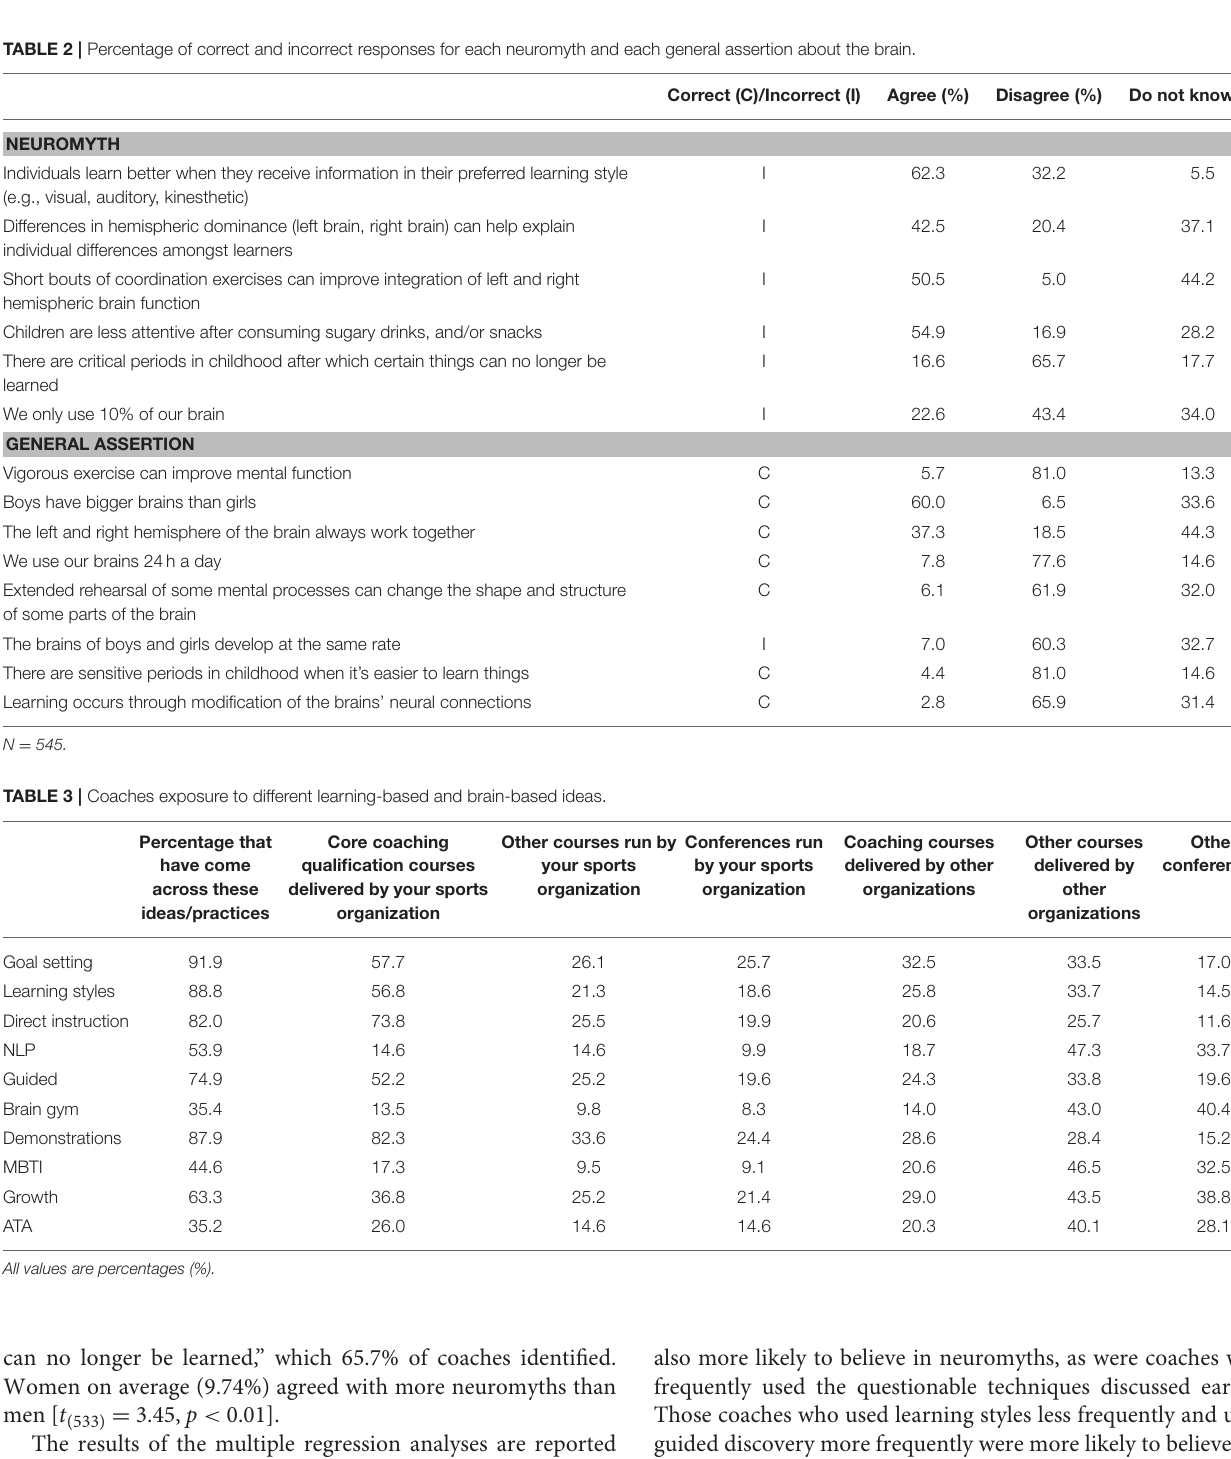
TABLE 2 | Percentage of correct and incorrect responses for each neuromyth and each general assertion about the brain. NEUROMYTH